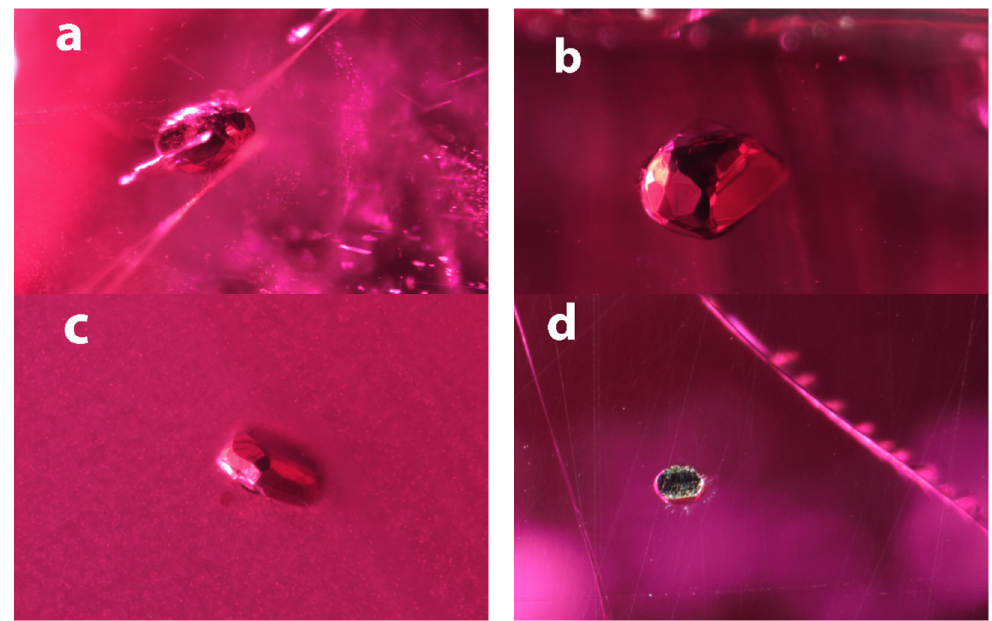
Figure 2. Inclusions in Mozambican rubies. ( a ) The inclusion in sample B1 is more egg shaped, but shows many small flat crystal faces. It is surrounded by a fracture that is reminiscent of an expansion fracture, which might be an indication of a temperature increase during its geological history after the corundum formed. FOV: 1.50 mm;( b ) The opaque inclusion in sample B2 show many larger crystal faces that do not seem regularly distributed. The overall appearance is rather spherical. FOV: 0.78 mm; ( c ) The inclusions in sample B3 are similar to B2 but appears flatter. FOV: 1.2 mm; ( d ) The inclusion in sample B4 was cut through during sample fabrication and shows the brassy color around the edges. FOV: 0.72 mm.